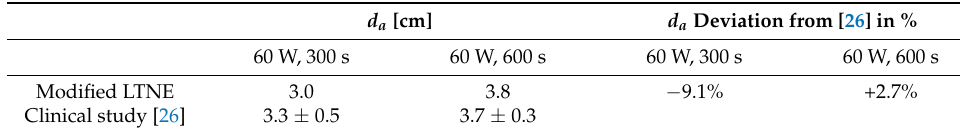
Table 2. Transverse ablation zone’s diameters achieved by the present developed LTNE model with variable porosity compared with experimental in vivo measures from [26].